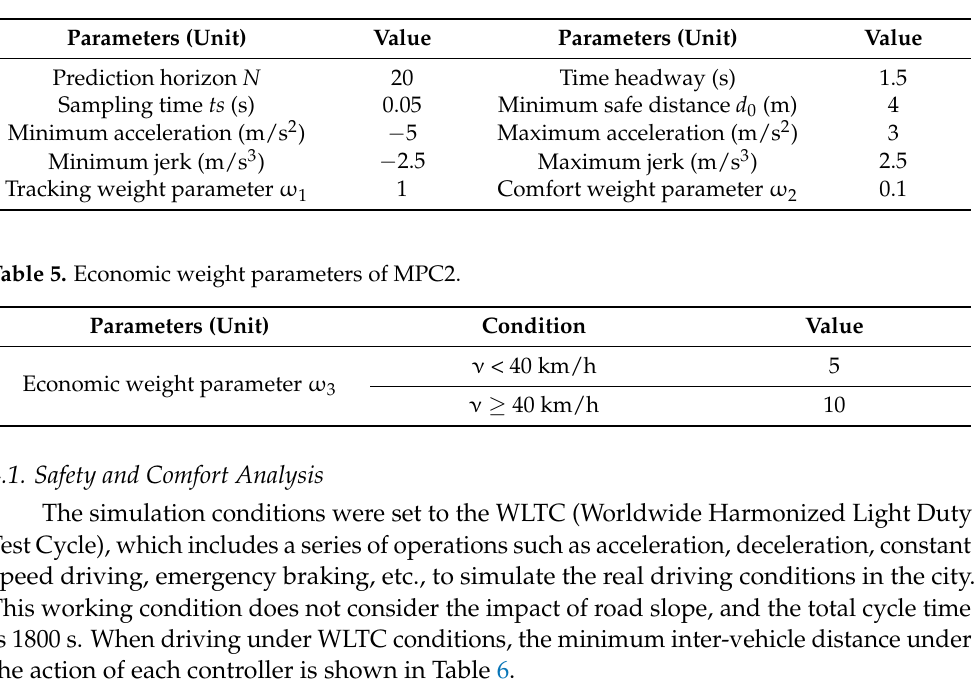
Table 4. Parameters in PID, SMC, MPC1 controllers.